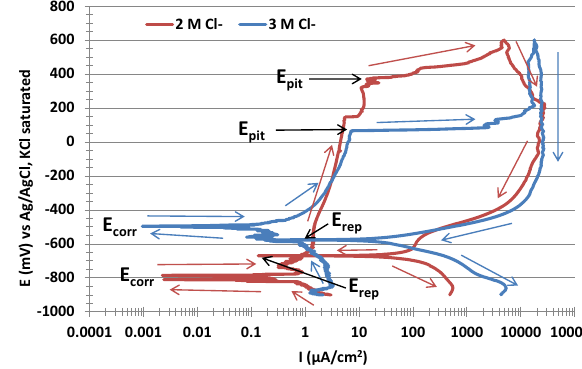
Figure 5: CPP of HSHCsw in deaerated electrolytes at pH 13.4 at 0.1, 0.25, 0.5, and 1 M Cl − . A complete CPP from − 900 to + 600 and then back to − 900 mV was performed for each Cl − concentration. Forward curves are plotted as solid lines and reverse curves are plotted as dotted lines for easy viewing and comparing.